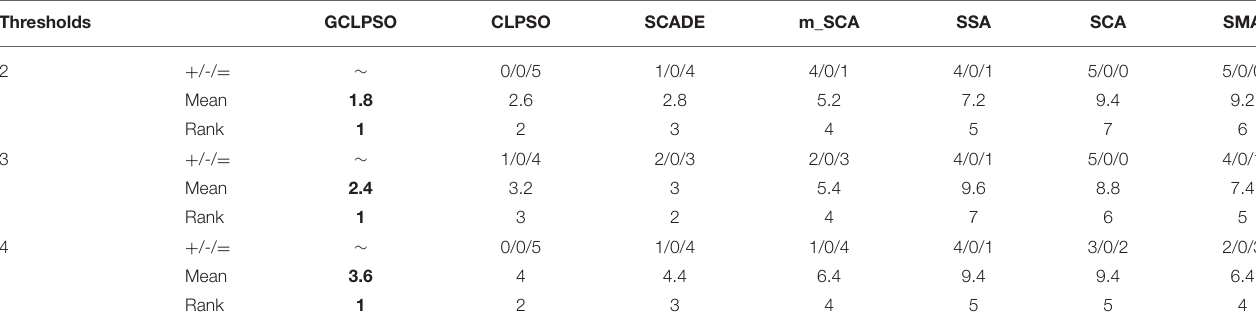
TABLE 7 | Results of the SSIM comparison by the Wilcoxon signed-rank test at each threshold level of maize gray spot disease.